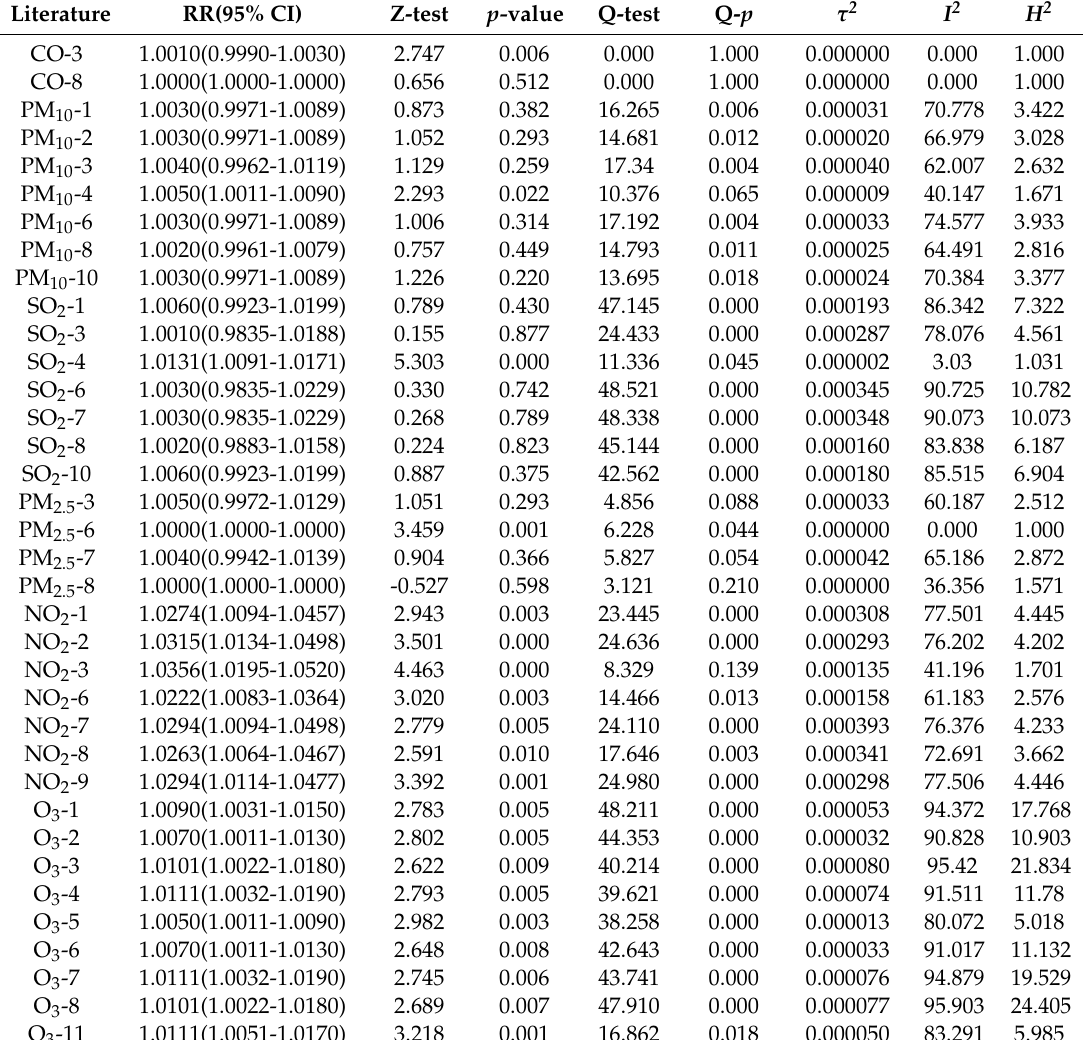
Table A4. Sensitivity meta-analysis using the leave-one-out